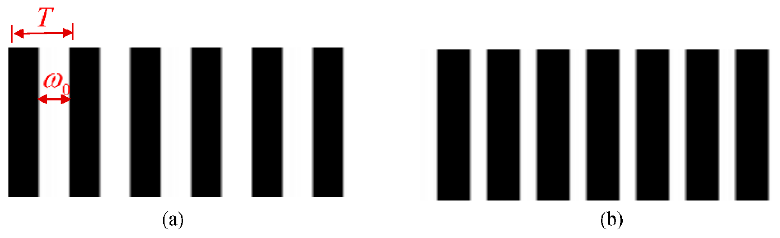
Figure 1. The binary gratings: ( a ) binary grating with 1/2 duty cycle; and ( b ) binary grating with 1/3 duty cycle. The color binary fringe projection (CBF) proposed by Fu et al. [24]. Three monochro ‐ matic binary fringes occupy 1/3 period, respectively, and are arranged periodically. When the binary fringes are encoded in red (R), green (G), and blue (B) channels as shown in Figure 2, by separating the captured color fringe pattern into R, G, and B components, respec ‐ tively, a real ‐ time measurement can be achieved. However, to capture the fringe images, a color CCD must be adopted, and generally the frame capturing rate may be limited. Figure 2. The features of the composite CBF and the segmentation. The schematic diagram of a real ‐ time 3D measuring method based on single ‐ shot quaternary grating projection is shown in Figure 3. The quaternary grating is encoded and saved into the flash memory of the (Digital Light Processing) DLP. The DLP projects the quaternary grating with the period width of 9 pixels onto the reference plane and the ob ‐ ject, and the project angle α is 27 degrees. At the same time, a high frame rate monochrome Charge ‐ coupled Device (CCD) camera is capturing the corresponding fringe pattern syn ‐ chronously on the same plane. Figure 3. Online 3D measurement system based on quaternary grating projection. The projected matrix of the quaternary grating is shown in Figure 4a. The three non ‐ zero gray levels of 1, 2, and 3 are arranged and encoded in equal width in sequence. Figure 4b shows the cutaway view of the single ‐ shot quaternary grating. When the quaternary grat ‐ ing is projected onto the reference plane and object, respectively, with DLP4500, by select ‐ ing the 2 ‐ bit coding mode, the correspondingly captured fringe pattern on the reference and the deformed pattern on the object are shown in Figure 4c,d. The shadow in the de ‐ formed pattern corresponds to the 0 grayscale in the quaternary grating projection as